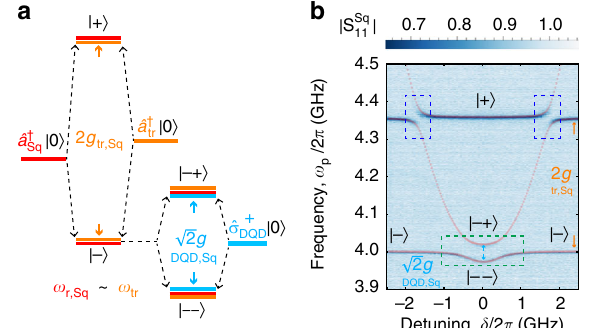
Fig. 2 Resonant interaction between the DQD charge qubit, the SQUID array resonator and the transmon. a Energy level diagram of the DQD- SQUID array-transmon system for the bias point considered in panel ( b ). The energy levels are colored in accordance with the code used in Fig. 1. j of the SQUID array resonator hybridized with the b Re fl ectance j S Sq 11 transmon and DQD as a function of the DQD detuning δ at the bias point discussed in the main text. Red dots are obtained by numerical diagonalization of the system Hamiltonian [see Eq. (1) in Supplementary Note 2], using parameters extracted from independent